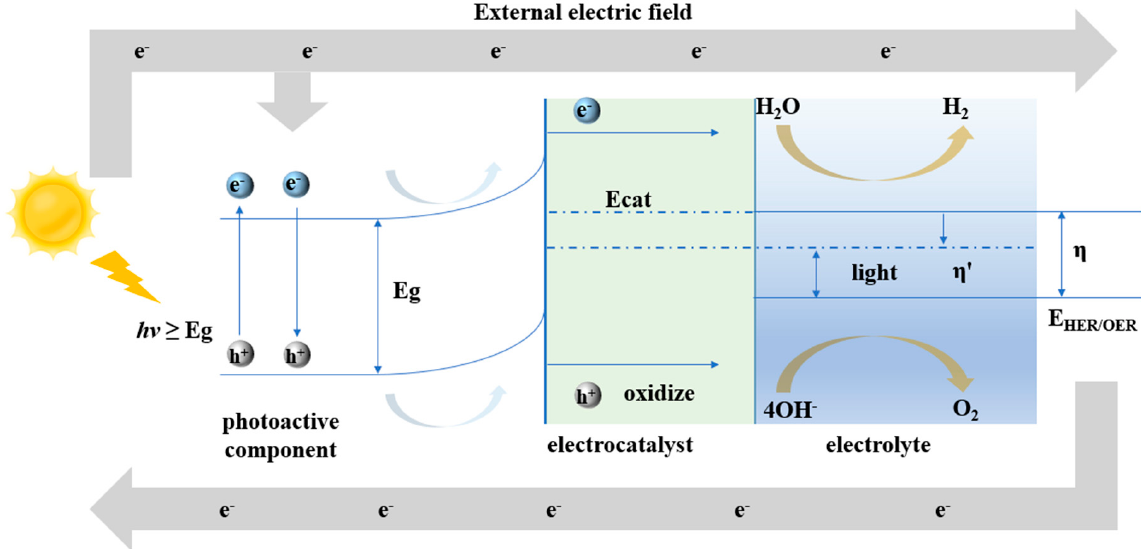
Figure 1. The working principle of a photogenerated carrier—assisted electrocatalyst.